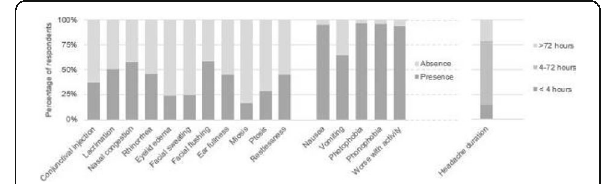
Fig. 1 (abstract P0442). See text for description